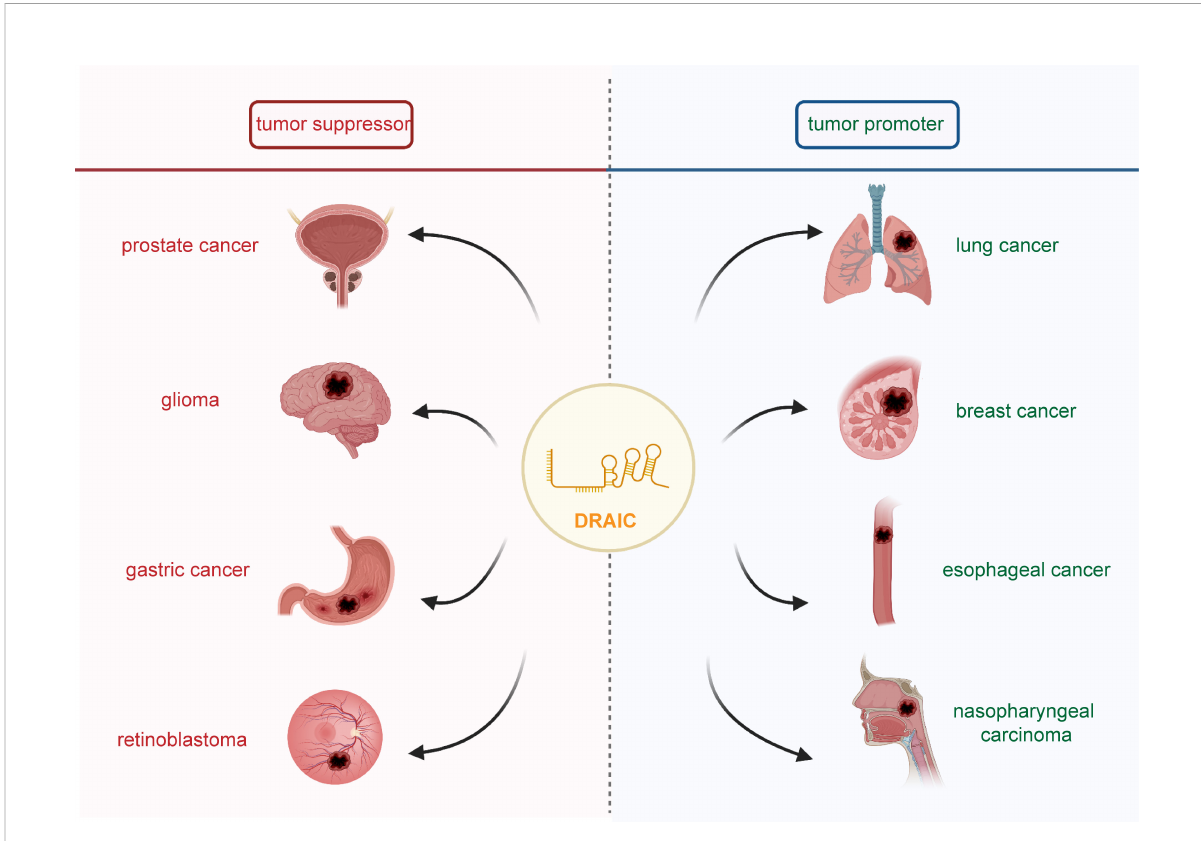
FIGURE 1 The role of lncRNA DRAIC in human cancers. It has been shown that lncRNA DRAIC acts as a tumor suppressor in prostate cancer, glioma, gastric cancer, and retinoblastoma. DRAIC also functioned as an oncogene in lung cancer, breast cancer, esophageal cancer and nasopharyngeal